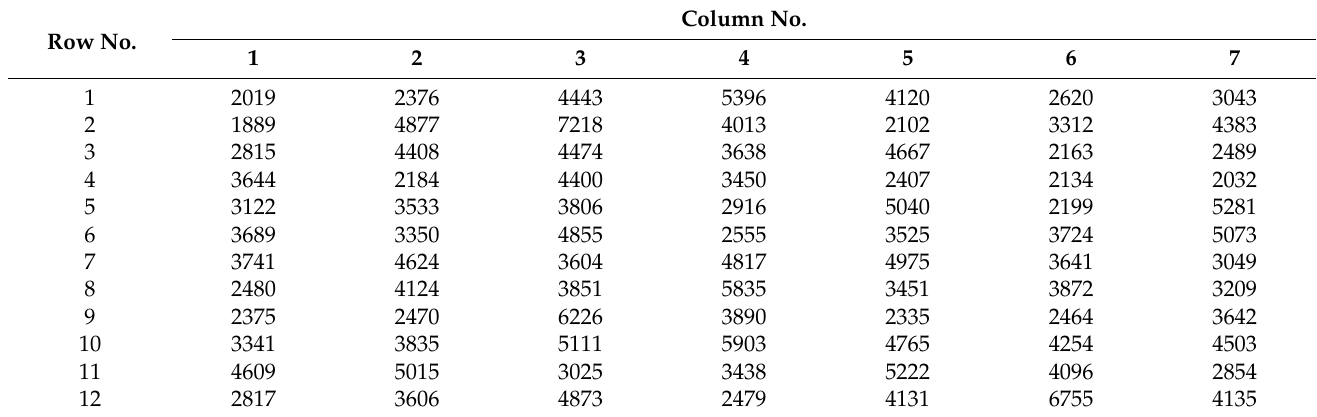
Table 1. Number of pixels of leaf area of lettuce seedlings at the age of 17 days.